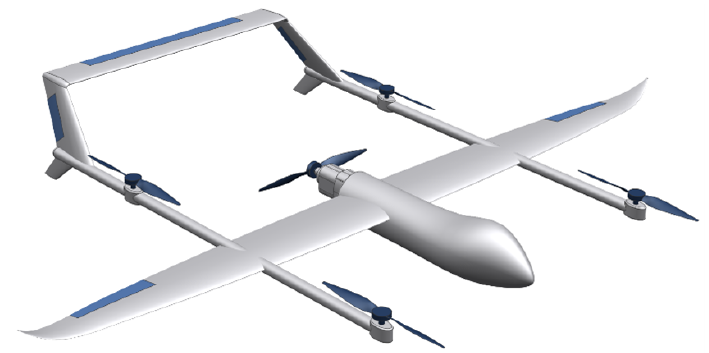
Figure 1. Hybrid VTOL UAV—Skyhunter from the ACoRUs Project